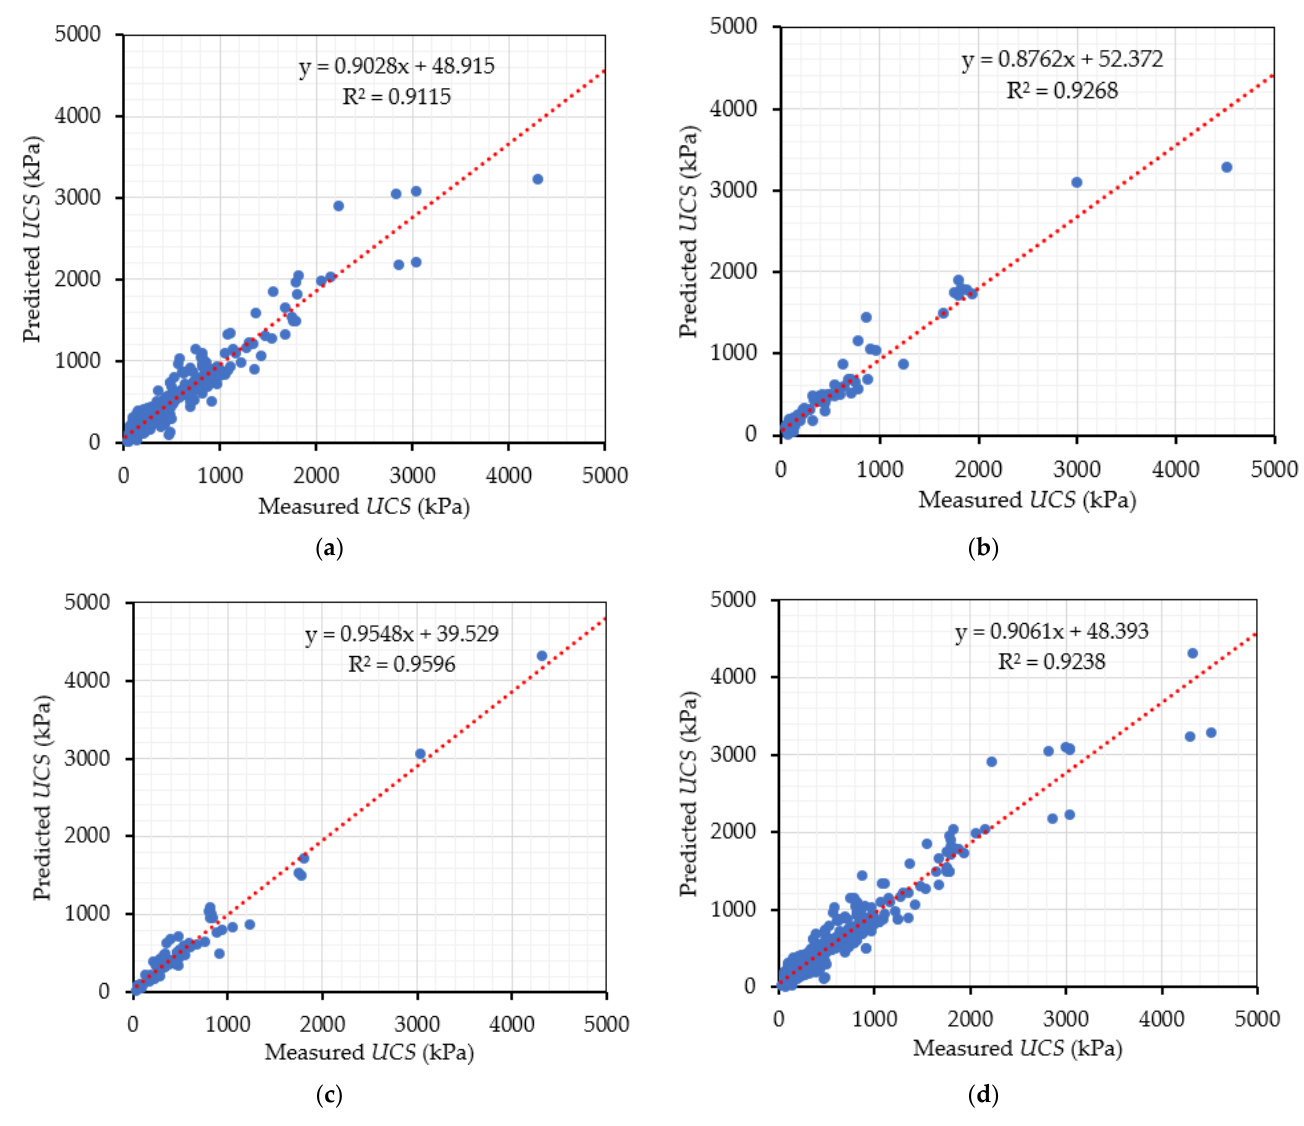
Figure 2. Performance of the proposed GEP model: ( a ) Training phase; ( b ) Testing phase; ( c ) Verifying phase; ( d ) Entire data. Golbraikh and Tropsha [33] provided some criteria as the external validation